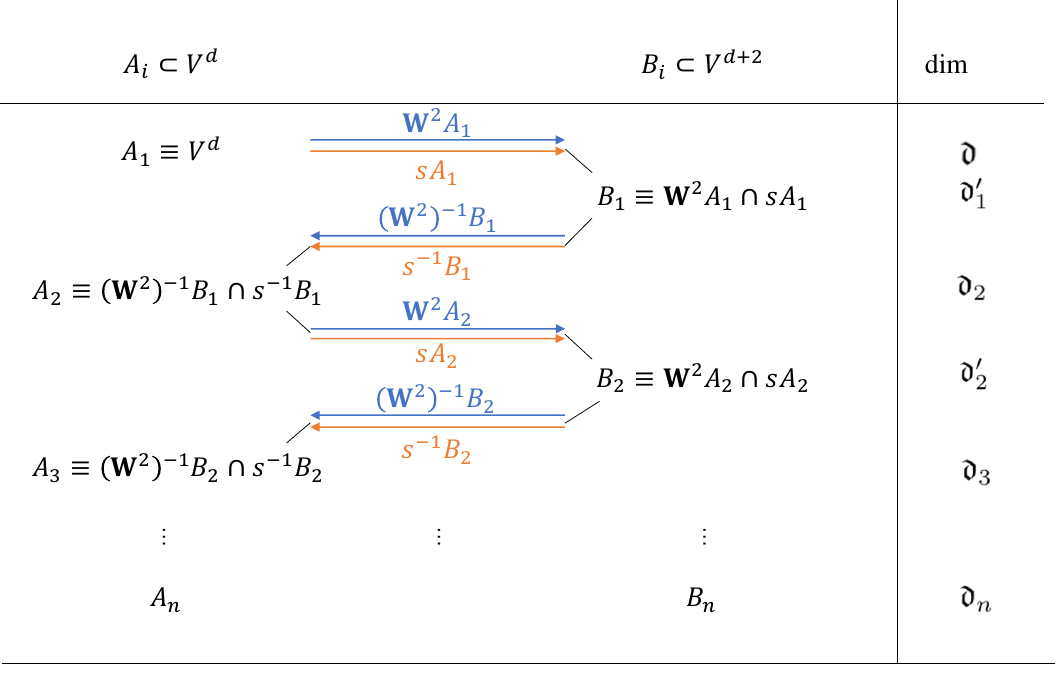
Figure 9 . The general procedure of Poincaré method for constructing Lorentz j-basis at dimension d . The spaces of amplitudes at dimension d and d + 2 are involved, whose subspaces are named A i and B i . Starting from A 1 = V d , we apply two maps — W 2 and the multiplication of s —